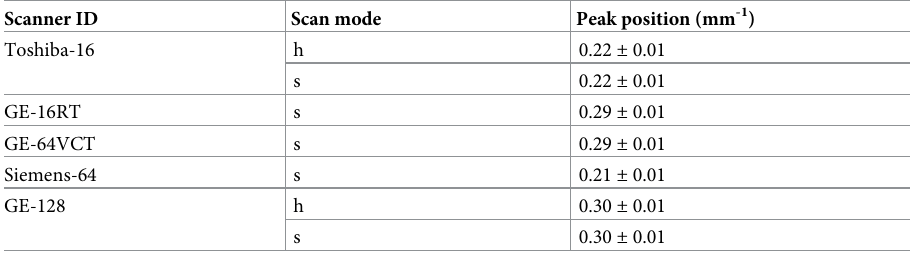
Table 5. Peak position of NPS curves for each CT scanner/acquisition